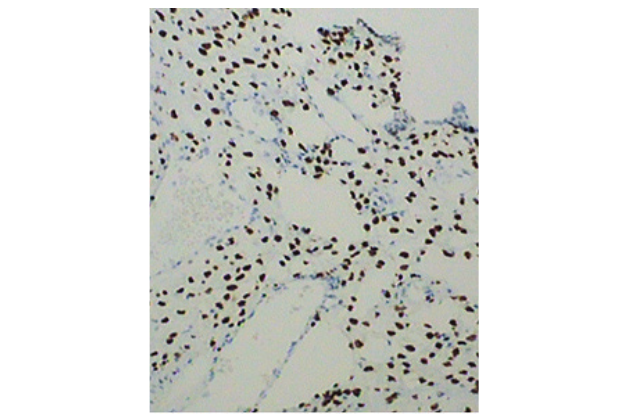
FigurE 3 − Strongly positive immunostaining for progesterone receptor (100×)